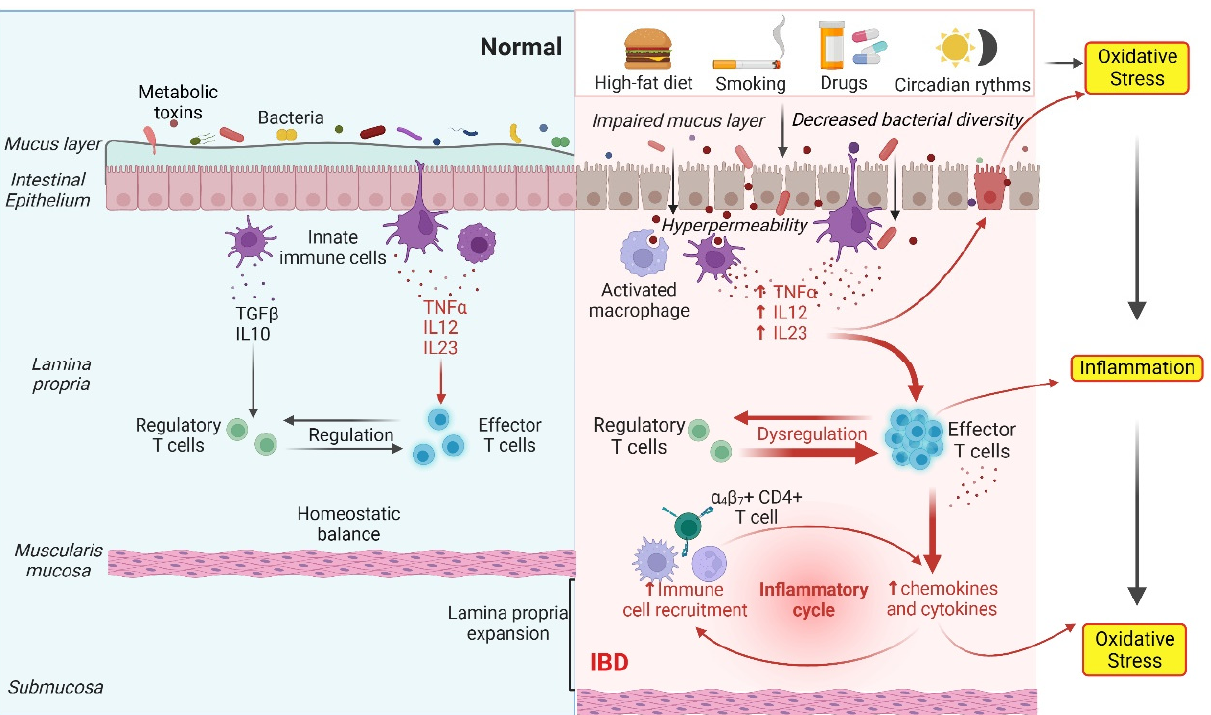
Figure 1. The pathogenic mechanisms of IBD. External pressures (high-fat diet, smoking, circadian rythms, and drug intervention) induce oxidative stress and can lead to gut dysbiosis and damage to the intestinal mucosal barrier, thus triggering a radical inflammatory response, which in turn stimulates the release of chemokines and cytokines, causing further oxidative stress and subsequent progression of IBD.